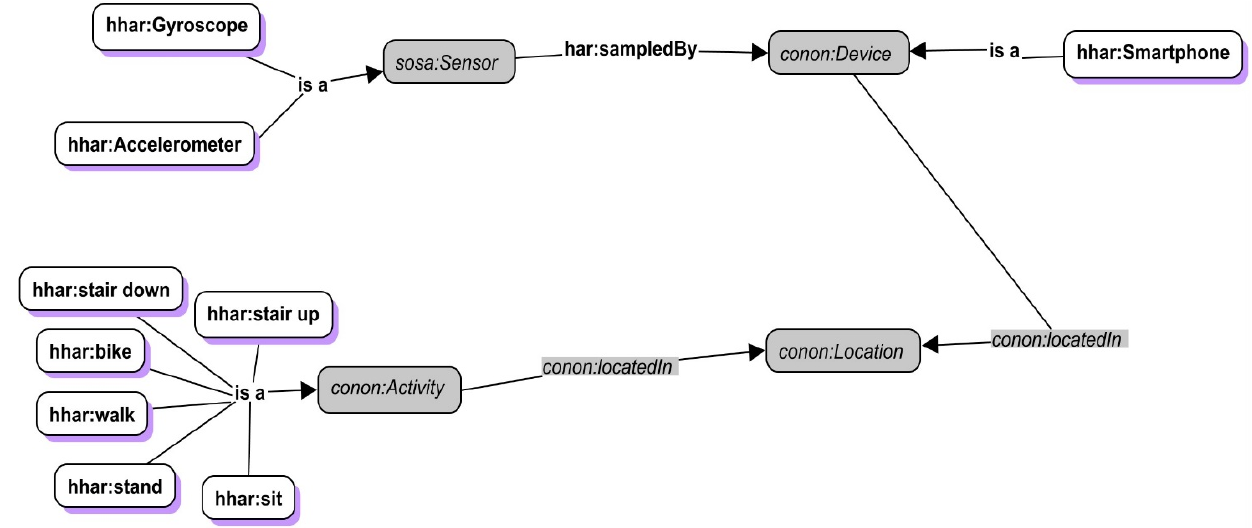
Figure 6. An excerpt of the user’s initial ontology-based model at 𝑡 0 .